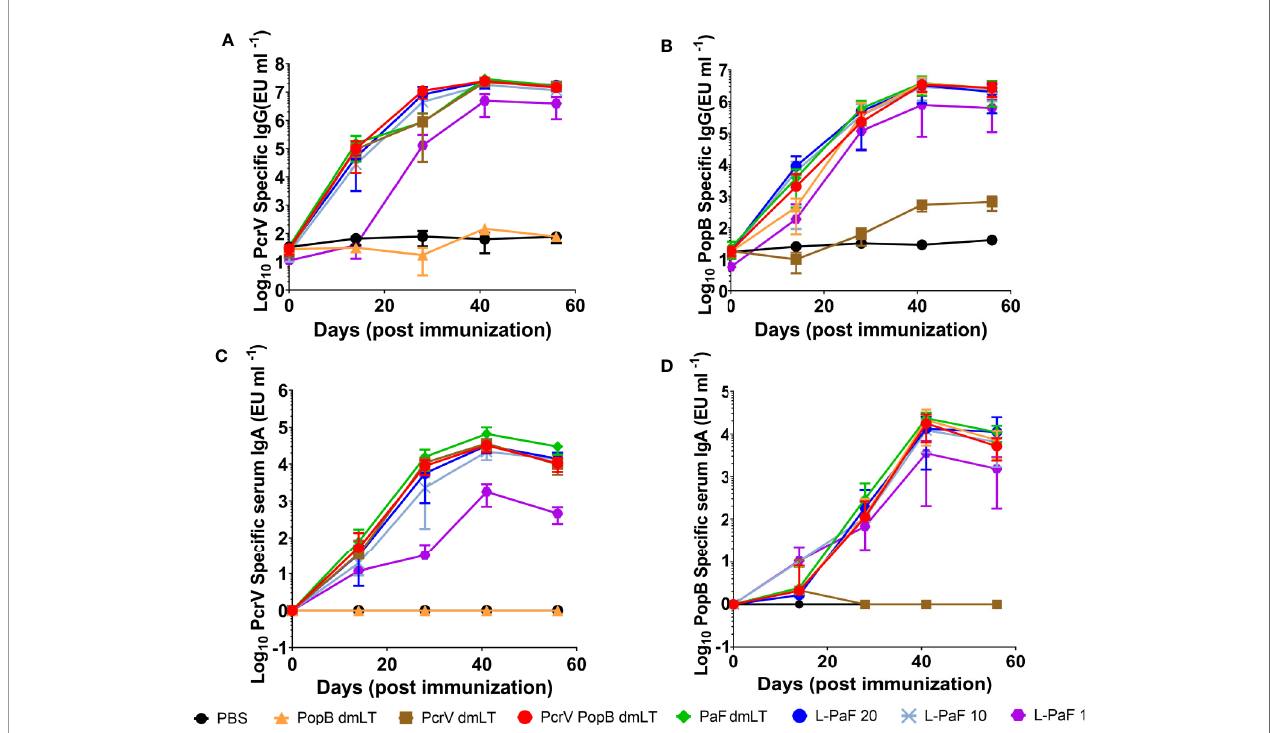
FIGURE 2 | Kinetics of serum IgG and IgA responses. Mice were vaccinated IN three times (Day 0, 14, and 28). Blood samples were collected and serum titers for IgG (A, B) and IgA (C, D) speci fi c for PcrV (A, C) or PopB (B, D) were measured by ELISA. The individual titers are represented as EU ml -1 . Each point represents the mean and error bars represent SD of each group